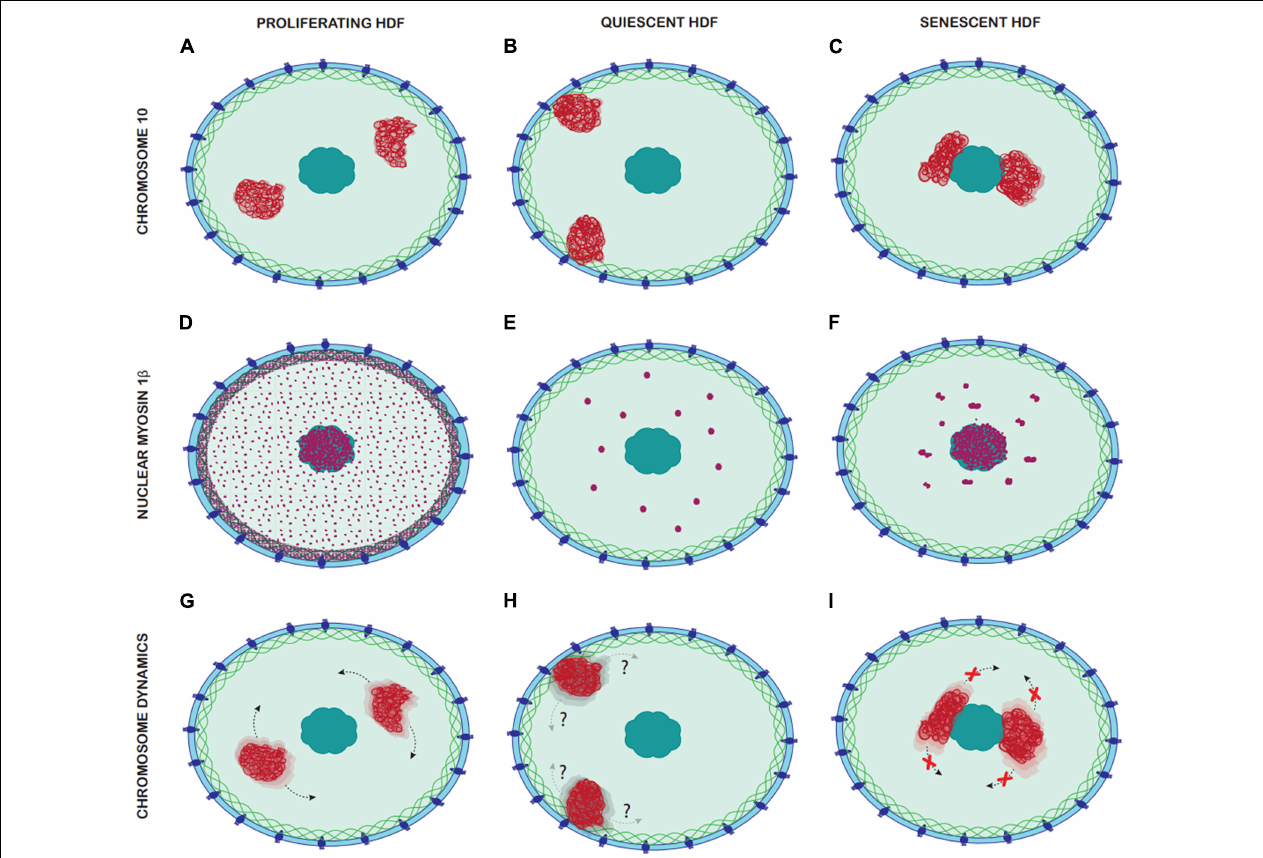
FIGURE 8 | Comparison of Chromosome 10 location, nuclear myosin 1 β distribution and chromosome dynamics in proliferating, quiescent, and senescent HDF. Panels (A–C) represent the different locations of chromosome 10 in proliferating, quiescent and senescent HDF, with chromosome 10 territories represented in red. (A) In proliferating HDF chromosome 10 occupies and intermediate nuclear position. (B) In quiescent HDF chromosomes 10 occupies a peripheral nuclear position. (C) In senescent HDF chromosome 10 occupies an interior nuclear position. Panels (D–F) represent the distribution of nuclear myosin 1 β in the nucleus of proliferating, quiescent, and senescent HDF, with nuclear myosin 1 β represented in purple. (D) In proliferating HDF, there is a dense accumulation of nuclear myosin 1 β in the nuclear lamina and nucleoli, and it is also distributed homogenously through the nucleoplasm. (E) In quiescent HDF, nuclear myosin 1 β accumulates in large spherical aggregates through the nucleoplasm. (F) In senescent HDF, nuclear myosin 1 β accumulates in large non-spherical aggregates through the nucleoplasm but is also densely accumulated in the nucleoli. Panels (G–I) represent the chromosome dynamics in proliferating, quiescent and senescent HDF, with chromosome 10 territories represented in red. (G) In proliferative HDF, chromosome 10 can be repositioned rapidly upon a stimulus via nuclear motors. (H) Chromosome dynamics in quiescent HDF remains unknown. (I) In senescent HDF, chromosome 10 cannot be repositioned upon stimuli and thus remains in the same nuclear